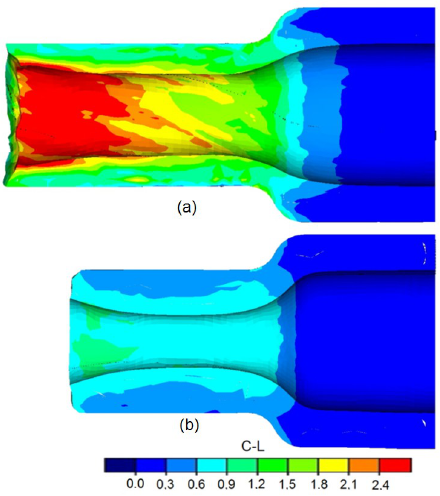
Figure 10. Finite elements method (FEM)-determined distributions of the Cockroft–Latham damage criterion: ( a ) for δ = 1.5, t o / D = 0.16 mm, v / n = 2 mm / rotation; ( b ) δ = 1.5, t o / D = 0.16, v / n = 6 mm / rotation.